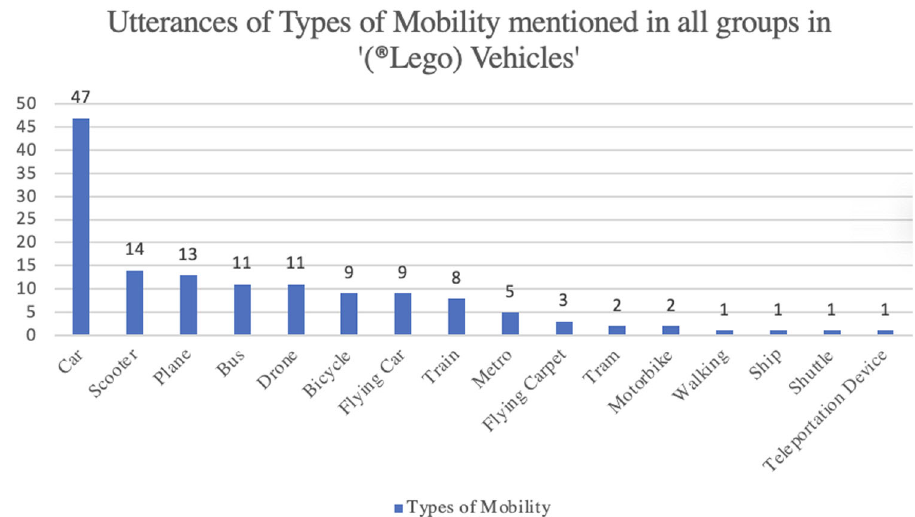
Fig. 3 Graph of utterances of types of mobility. Graph of utterances of types of mobility mentioned in all groups when referring to their ® Lego